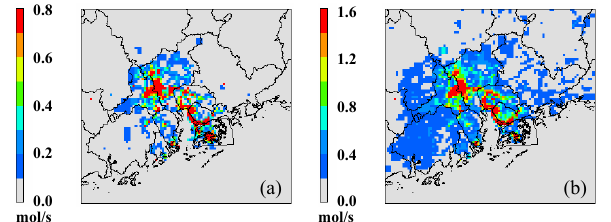
Fig. 2. NO x (a) and VOC (b) emissions in the 4-km grid at 12:00local standard time (LST) on 16 October 2004.